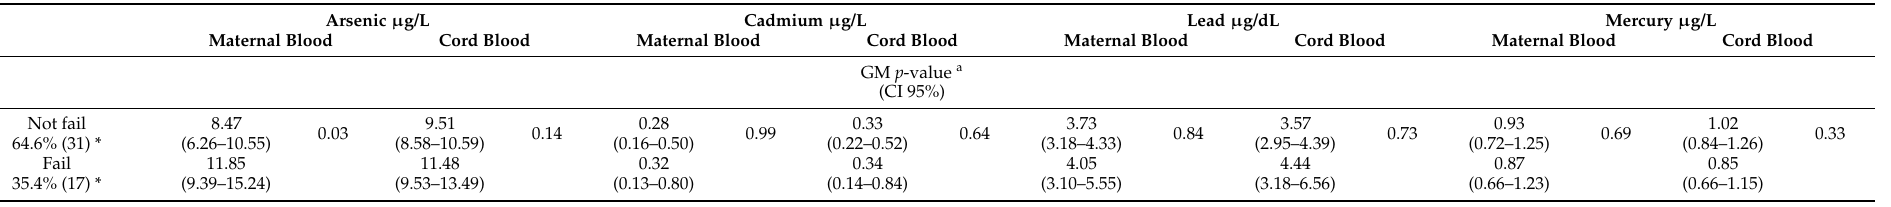
Table 5. Geometric means of metal concentrations in maternal blood and cord blood of the “not fail” and “fail” groups in the DDST-II evaluation, Rio de Janeiro, Brazil, 2018.